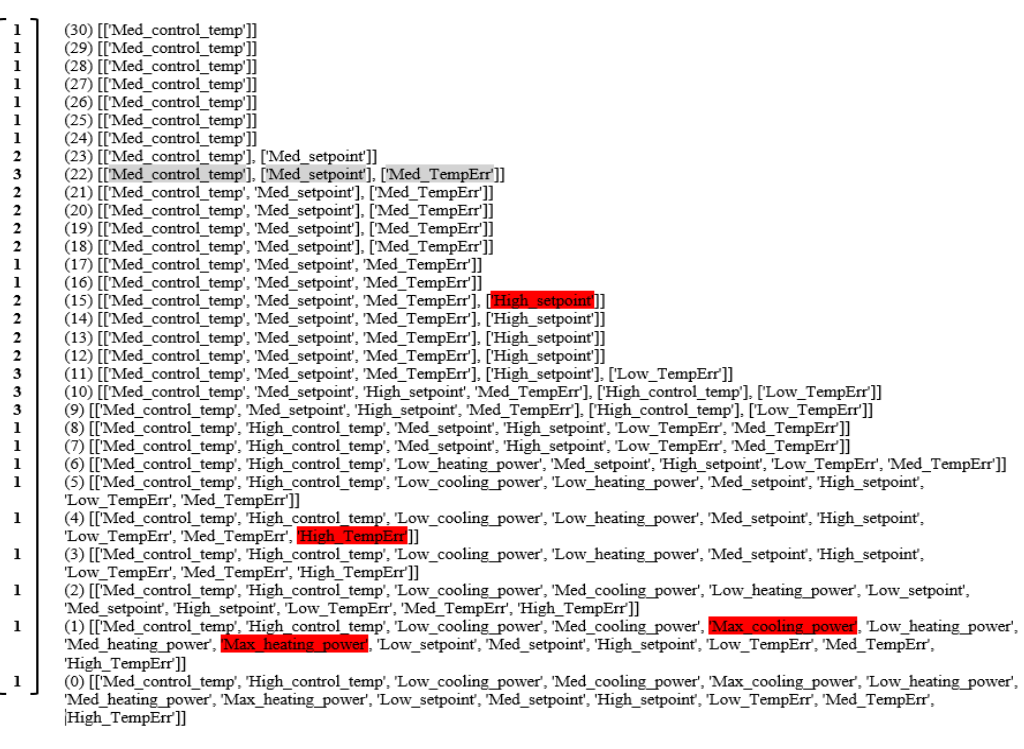
Figure 8. The q–connectivity list and corresponding state Q-vector. The left-hand column is the state Q-vector, the number in the parentheses indicates the q-level, the square brackets indicate the connected components. The highest q-value (30) shows for this time interval 31 TUs were in state medium control temperature, although only 24 TUs had medium set point (q = 23), while 16 TUs had a high set point (q = 15). A total of 12 TUs had low temperature error, while 5 TUs had high temperature error, 2 TUs were at maximum cooling power and maximum heating power. Using the incidence matrix as shown in Figure 5, it is possible to drill down to see which TUs are exhibiting anomalous behavior in an automated manner.